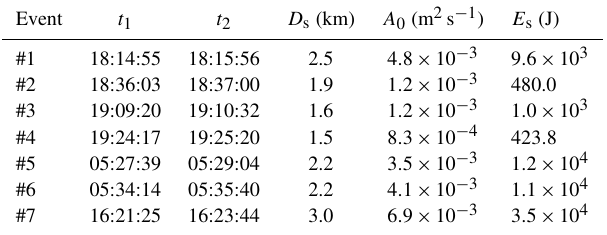
upper panel), avalanche #5 at 2900 m a.s.l. on the NE side (Fig. 6b, upper panel), avalanche #6 at 3010 m a.s.l. on the WNW side (Fig. 6c, upper panel), and slush flow #7 at 2430 m a.s.l. on the W side (Fig. 6d, upper panel). The second set of residual distributions shows avalanche #1 at 2110 m a.s.l., which is 230 m from the NW road where it im- pacted (Fig. 6a, lower panel); avalanche #5 is estimated at 2270 m a.s.l., which is 140 m from the NE road where it im- pacted (Fig. 6b, lower panel); avalanche #6 is estimated to be at 2540 m a.s.l., which is in the middle of the flow